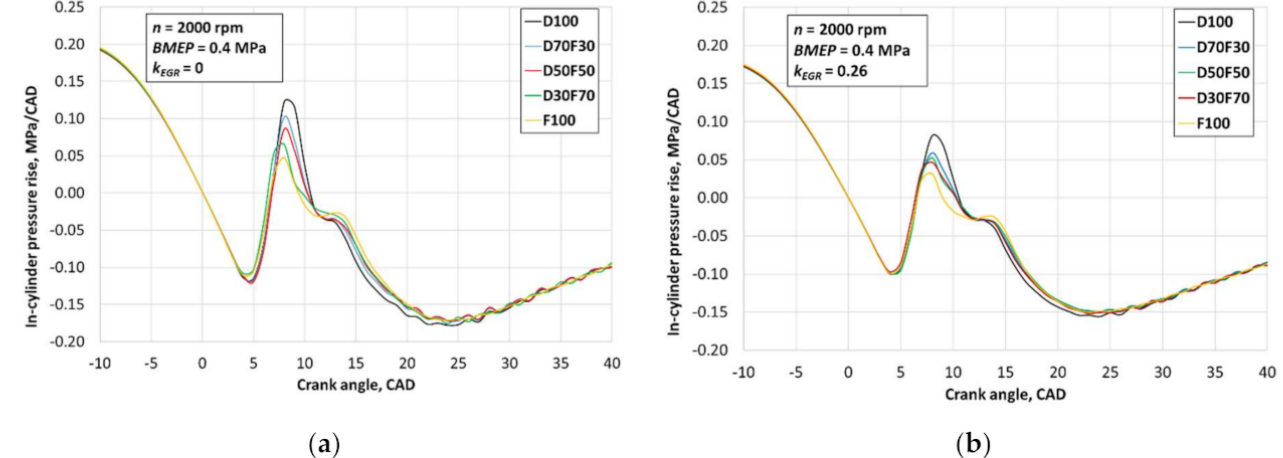
Figure 5. Pressure rise in-cylinder depending on the fuel composition with ( a ) EGR off and ( b ) EGR on. When EGR was off and the engine ran on conventional diesel, the maximum com- bustion pressure in the cylinder was ~6.14 MPa and, when EGR was on, it was ~5.5 MPa (~10% lower) (Figure 6). When using pure chicken fat and its mixtures with diesel, the maximum combustion pressure declined to ~6.0 MPa and ~5.4 MPa, respectively, even though the pressure of the end of compression increased. It was observed that when using diesel and its mixtures with chicken fat, the maximum combustion pressure was reached at ~11 CAD ATDC, and when using chicken fat, it was reached 2 CAD earlier. This was due to a later heat release, where the piston came down and the pressure did not rise.